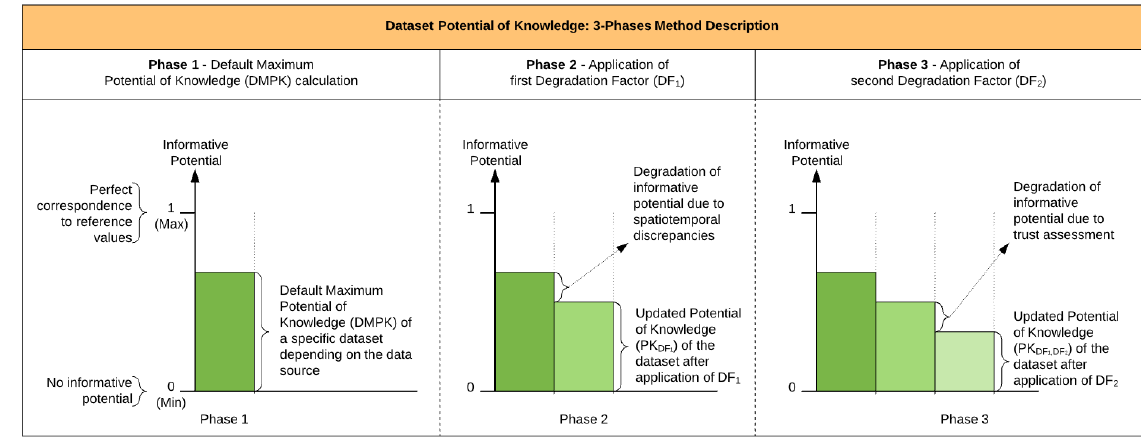
Figure 7. Three-phases method description. The figure shows the progressive degradation in the assessment of a dataset’s informative potential when compared to the originally required level of information. Table 1. List of assumptions made for the development of the presented